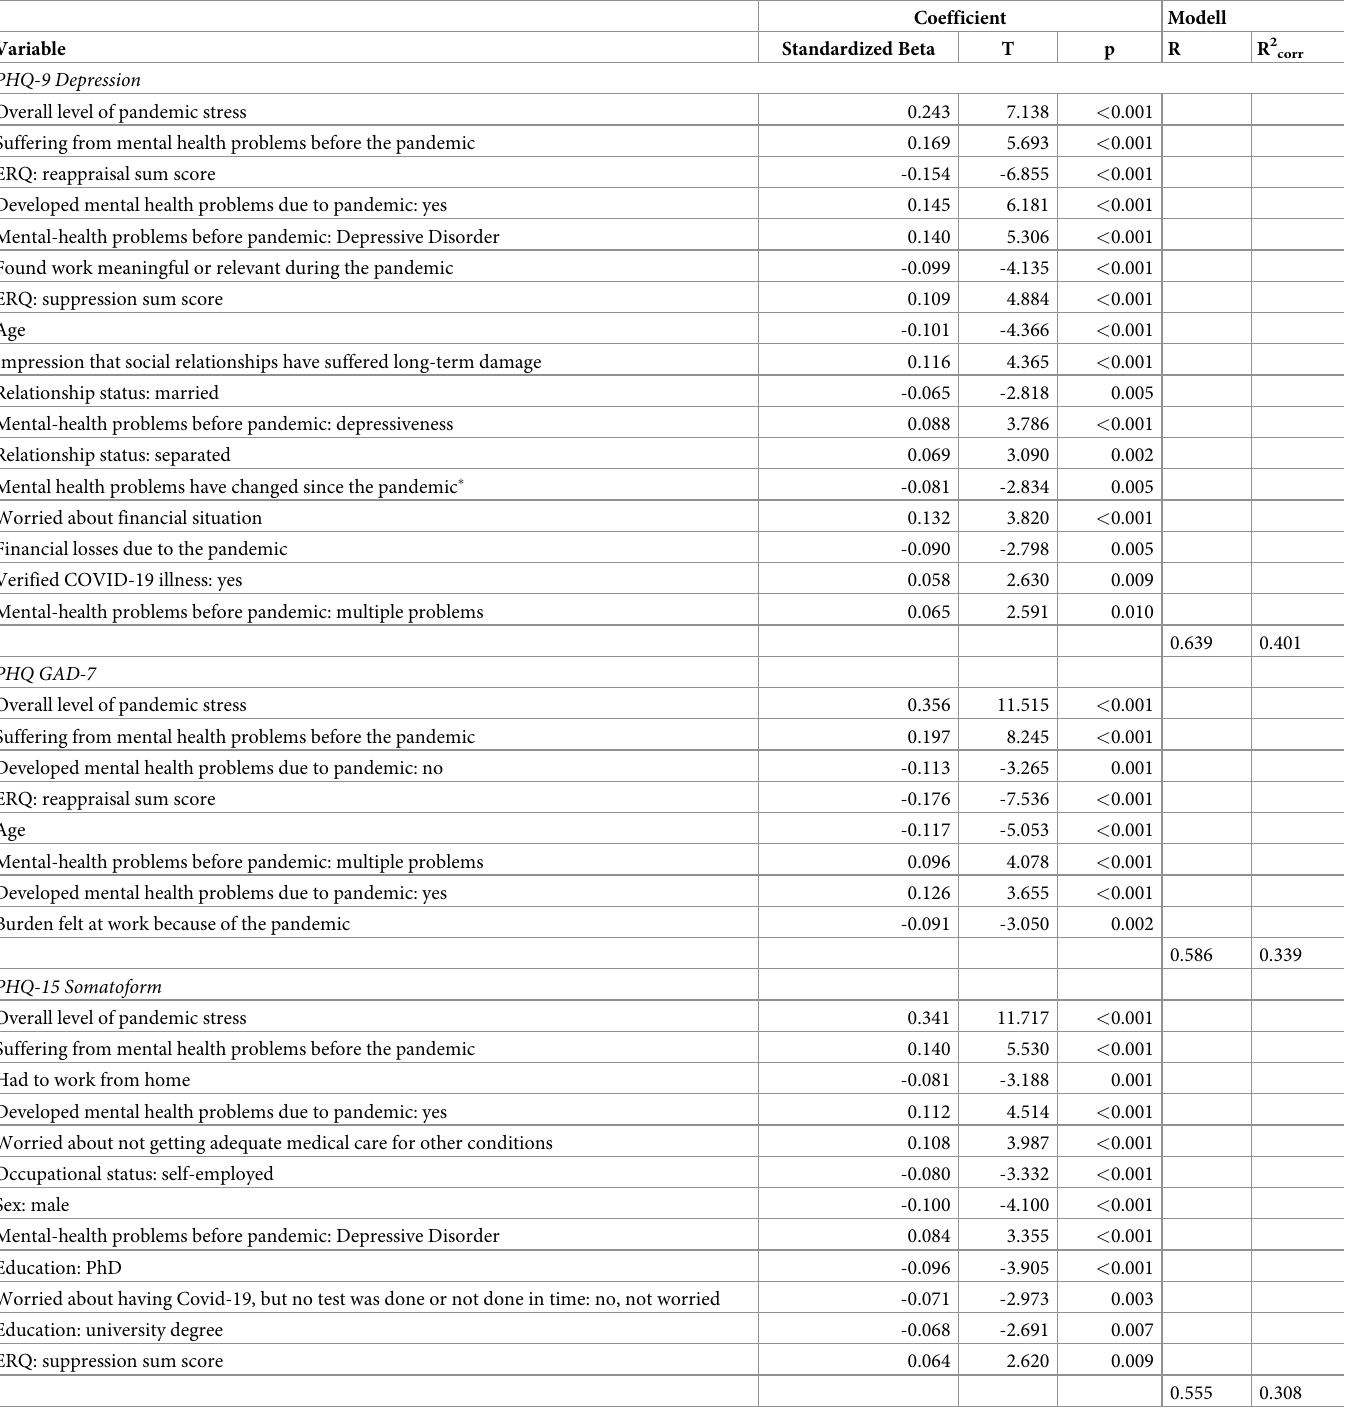
Table 2. Final stepwise regression models on the PHQ